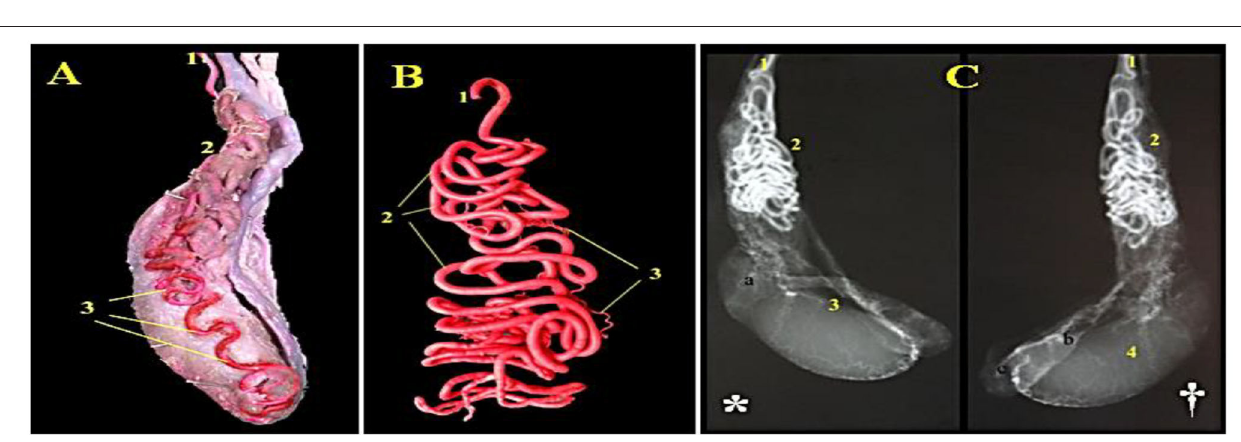
FIGURE 2 | Magnetic resonance images (MRI) of a right whole camel testis (A–E) and epididymis (E, F) showing sagittal section scanned by different series; T1-Spin Echo MR [ (A) : Front view; F: Lateral View], T2-Fast Spin MR (B) , 3D Fast-Spoiled Gradient-Echo MR (C,D) , 3-Plane Localizer MR (E) , T2 Spin-Echo of MR (G) , and 3-DFastSpoiled Gradient-Echo of MR (H) . MT: Mediastinum testis, T.A: Tunica albuginea, C.E & C. Epididymis: Cauda epididymis, T.LP: Testis lowers part.